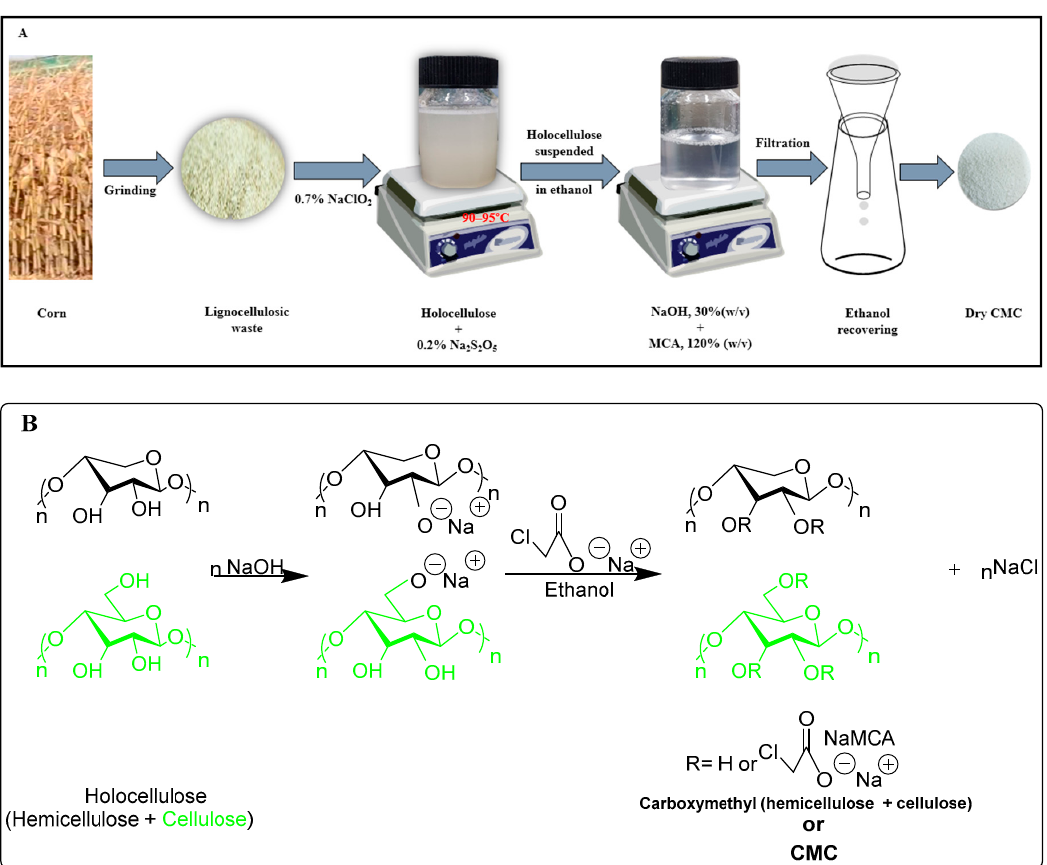
Figure 1. Schematic diagram of synthesizing of carboxymethyl cellulose (CMC) from holocellulose ( A ). Reaction mechanism of carboxymethylation of holocellulose (hemicellulose and cellulose) ( B